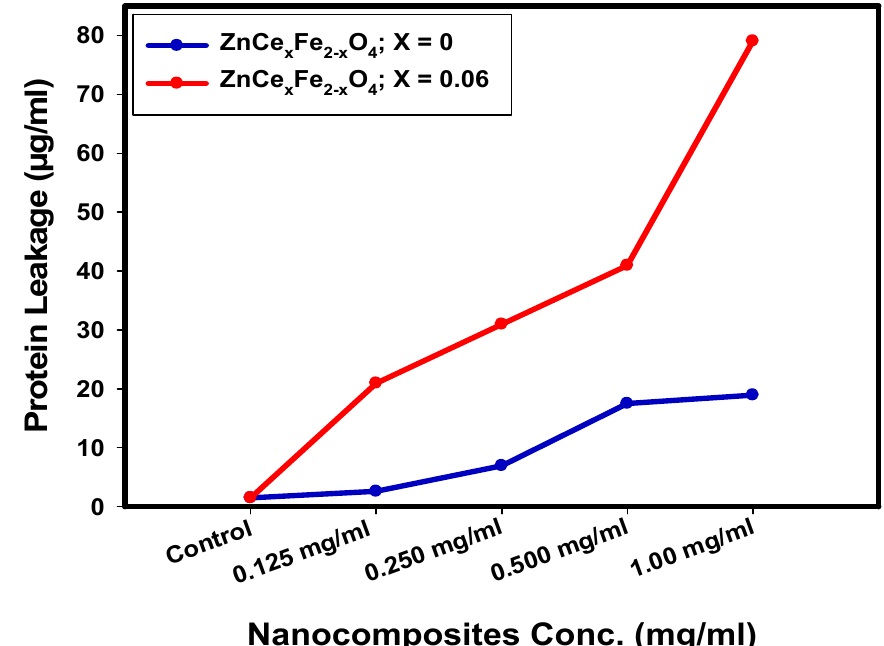
Figure 10. The effect of ZnCe x Fe 2 − x O 4 ; X = 0 and 0.06 on the protein leakage from S. aureus cell membranes.